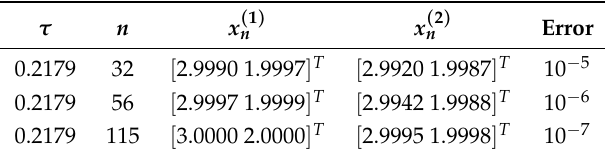
Table 4. x 0 = 2 ∗ rand ( 2,1 ) , results with bounded